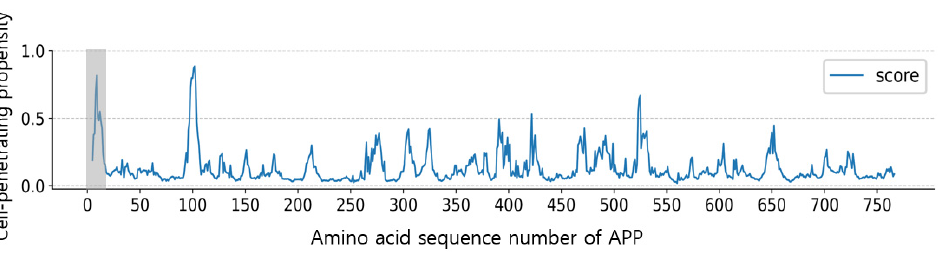
Figure 6. Cell-penetrating propensity of residues in the APP protein predicted by the AiCPP model, with the identified CPP peptides (1–17) highlighted in a gray box.